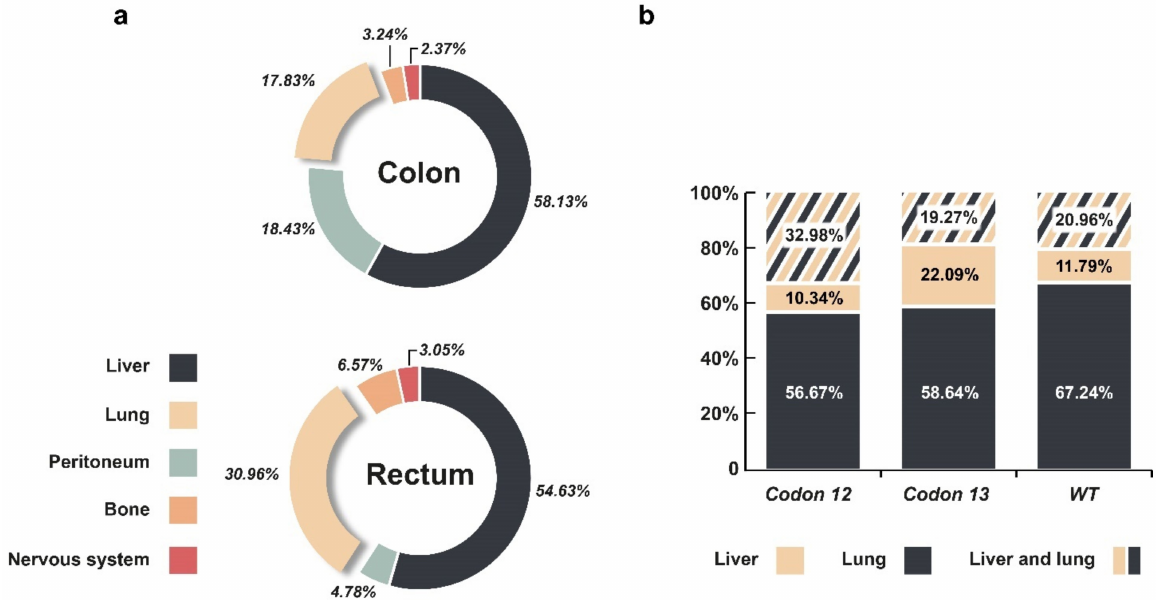
Figure 3. ( a ) Frequency of metastasis sites in CRC patients. Distributions of the metastatic sites in colorectal cancer patients (n = 27,506) were extracted from cohort data of Riihimaki et al. and Holch et al. [80,81]. ( b ) Frequency of single (liver or lung) metastasis and the combined appearance (liver and lung) metastasis among codon-12 and codon-13 mutant and wild type KRAS patients. Raw cohort data from He et al., 2020 and Jones et al., 2017 were normalised and pooled